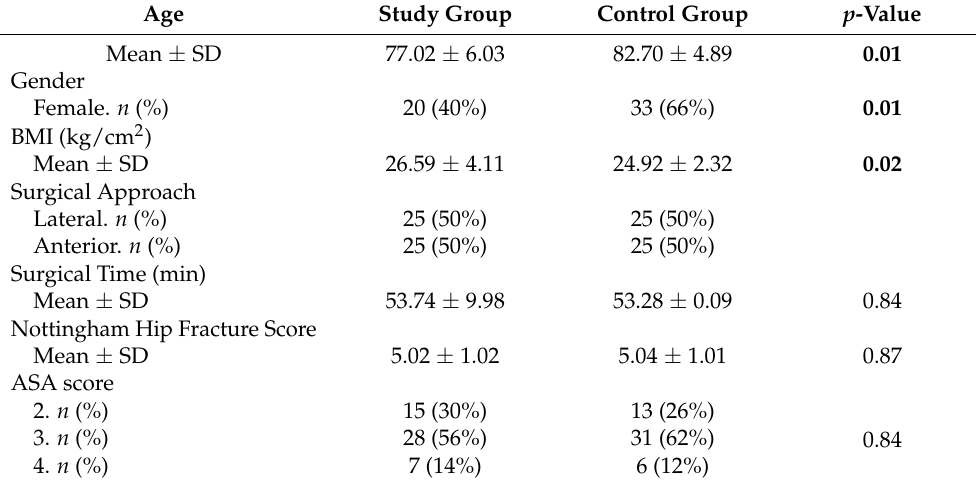
Table 1. Main data of the study (hundred patients, BMI: Body Mass Index).